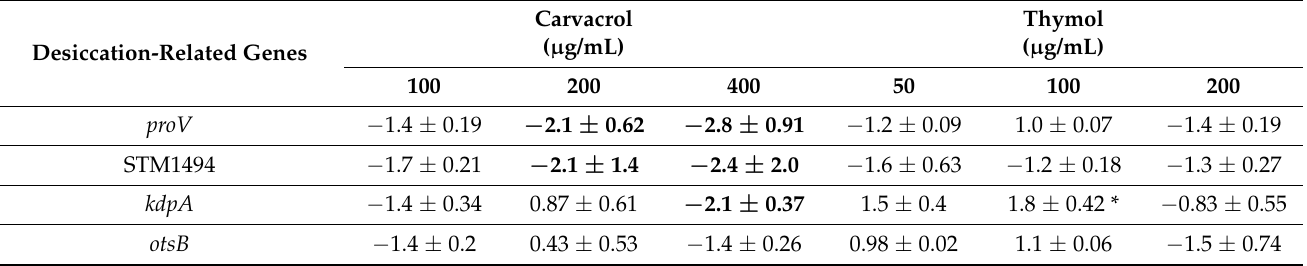
Table 1. Relative expression, determined as expression ratio *, of desiccation-related genes in desic- cation-adapted Salmonella Tennessee, which was treated with carvacrol and thymol and compared to the untreated desiccation-adapted cells.